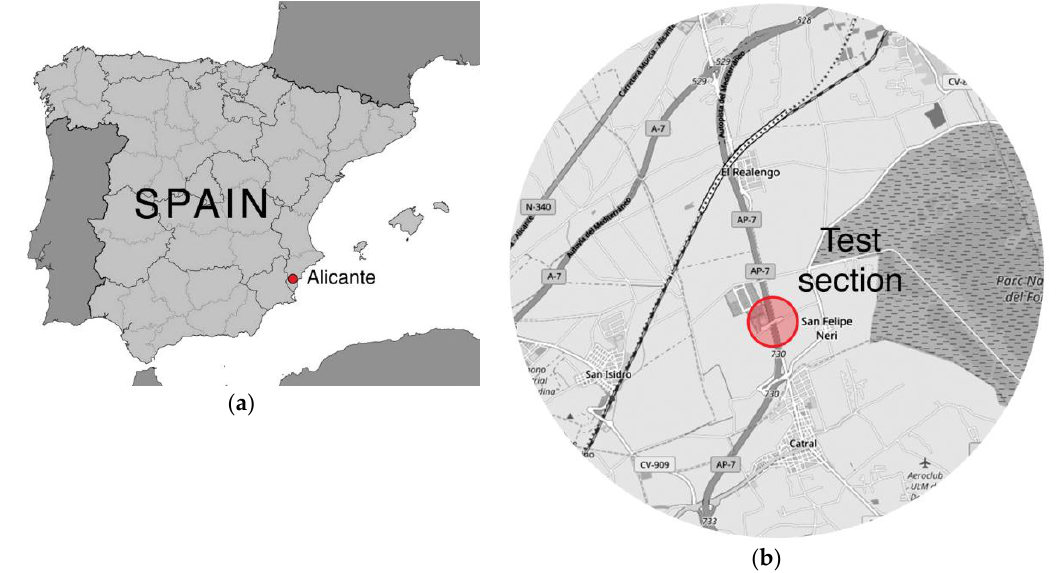
Figure 1. Test section location: ( a ) in Spain; ( b ) at CV-904 two-lane highway (Crevillente-Almoradí).